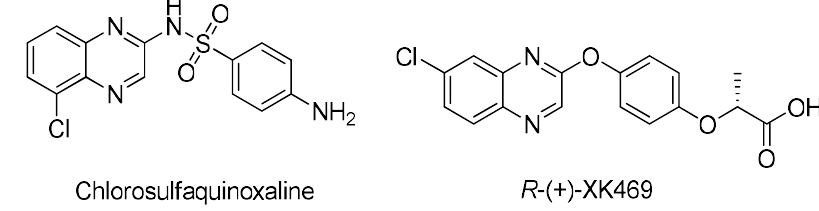
Figure 1. Examples for drugs containing quinoxaline moiety.